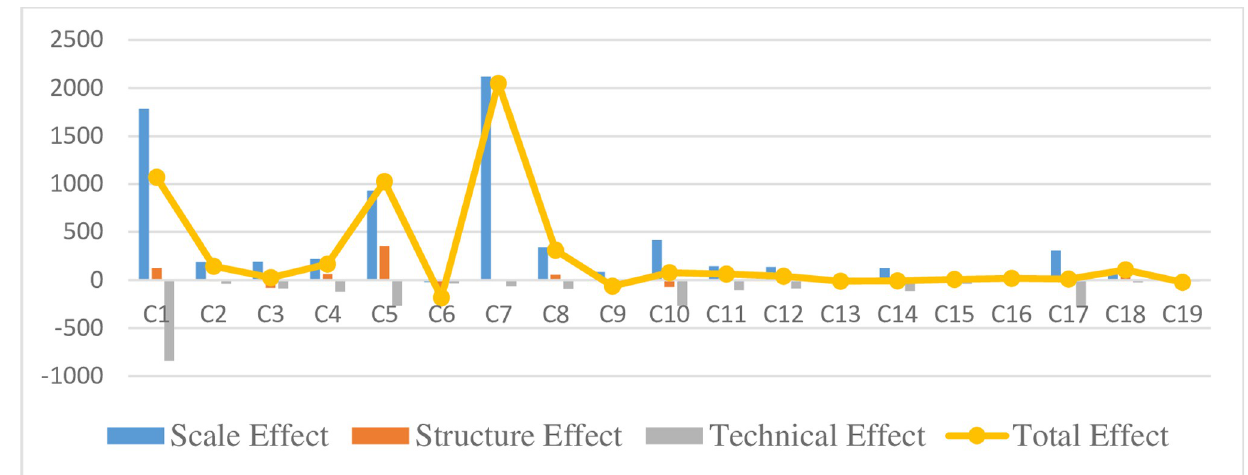
Fig 4. Decomposition of the influencing factors of solid waste emissions (unit: 10,000